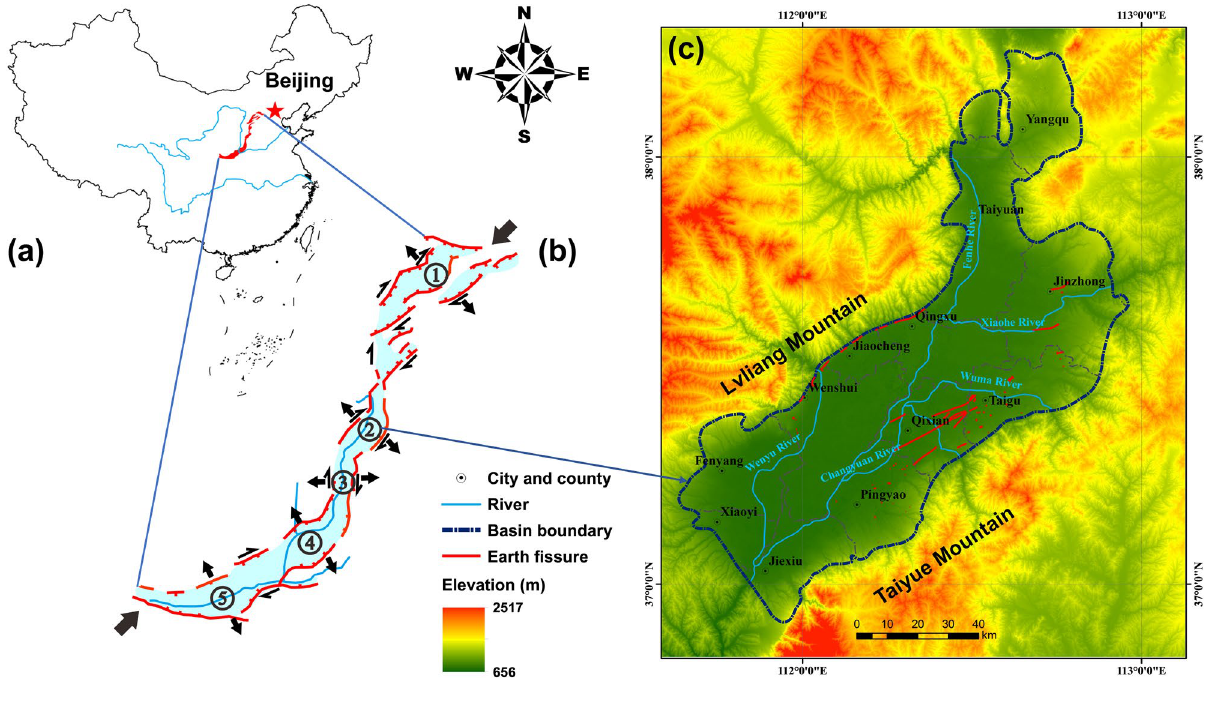
Figure 1. Distribution of earth fissures in the study